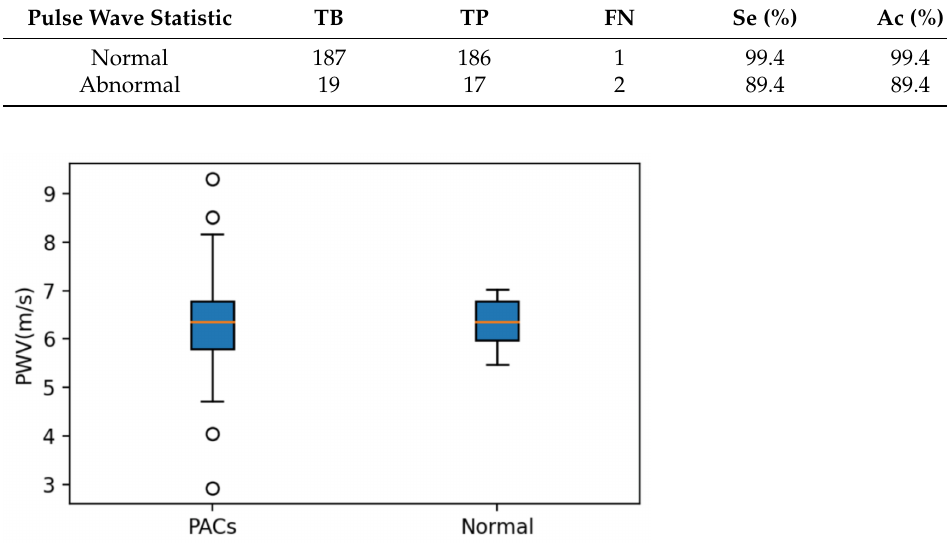
Figure 17. PWVs of PACs compared to the statistical distribution of PWV with the PAC removed (normal pulse wave).